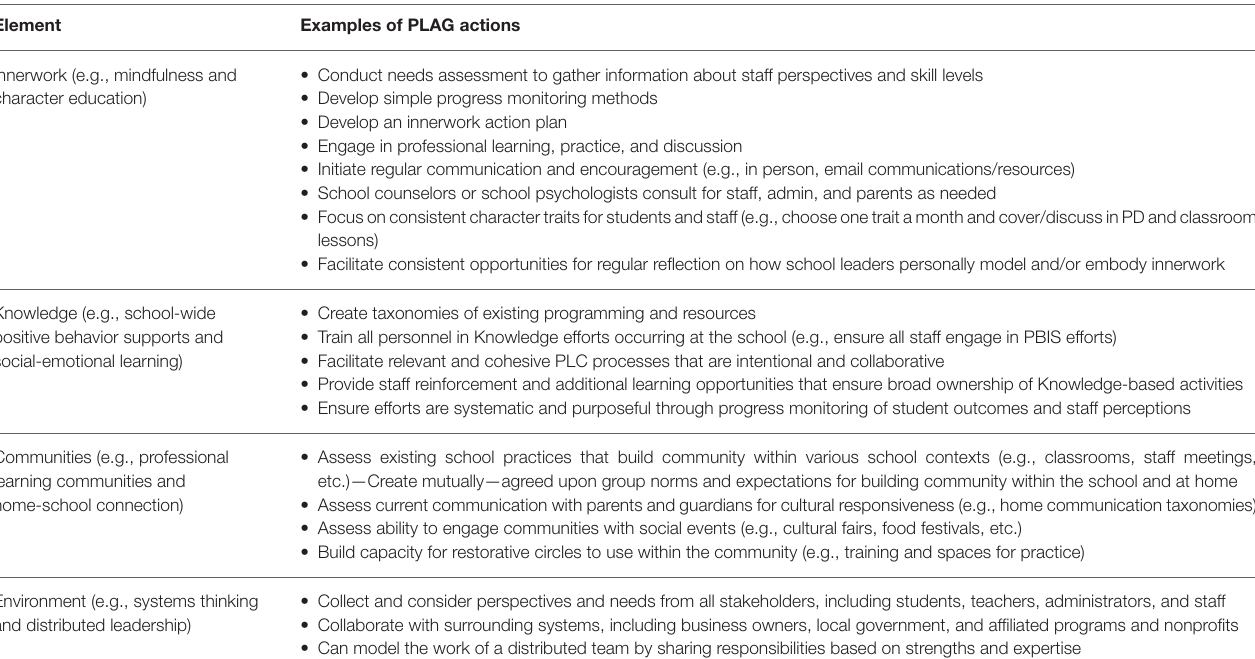
TABLE 1 | PLAG Actions and Necessary Structures and